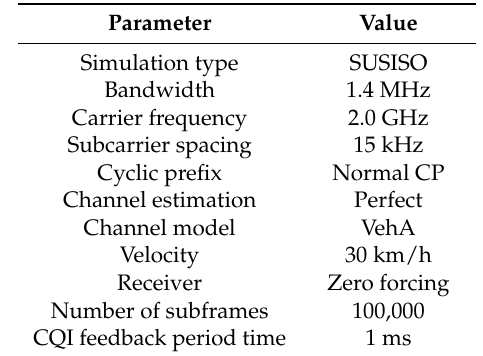
Table 3. Simulation parameters for system throughput of the proposed channel quality indicator (CQI) feedback scheme.